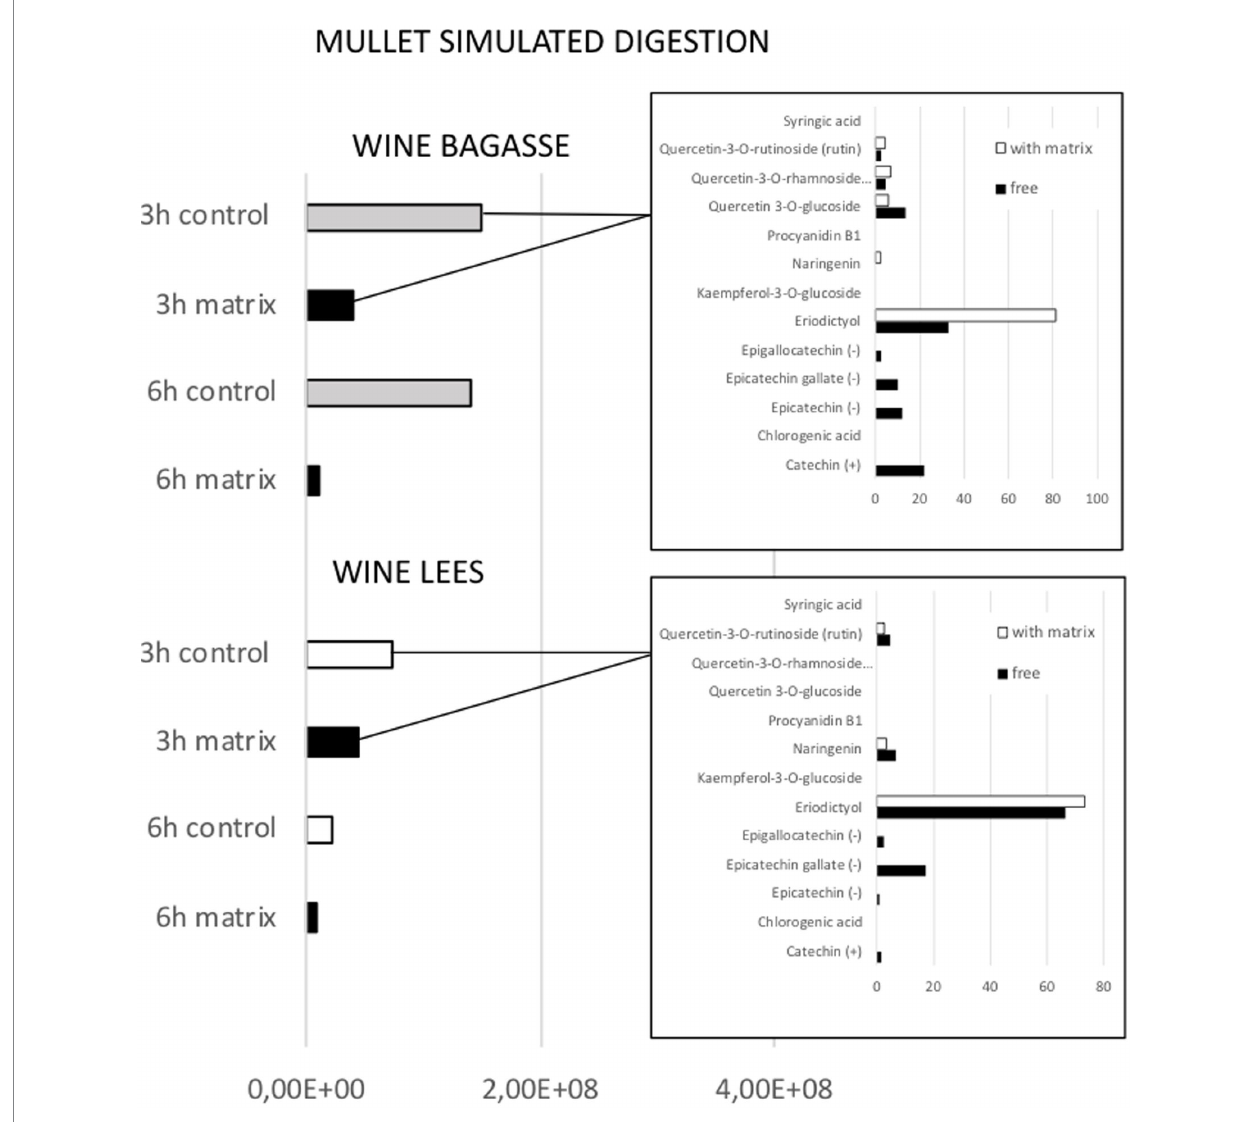
FIGURE 5 Effect of feed matrix on the release of total phenolic compounds from either wine bagasse or lees, measured at two different digestion times (3 and 6 h) during simulated digestion of flathead mullet. Values are expressed as the sum of all peak areas detected in samples measured by UHPLC. The release of specific types of phenolics after 3 h digestion of either bagasse or lees are shown in the small graphs, being values expressed as % of the total amount of phenolics measured in the presence or absence of feed